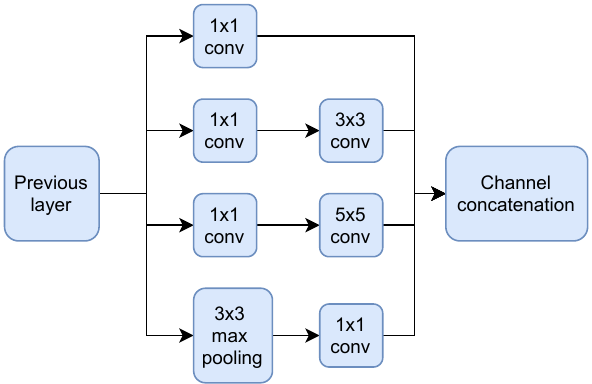
Figure 6. The Inception